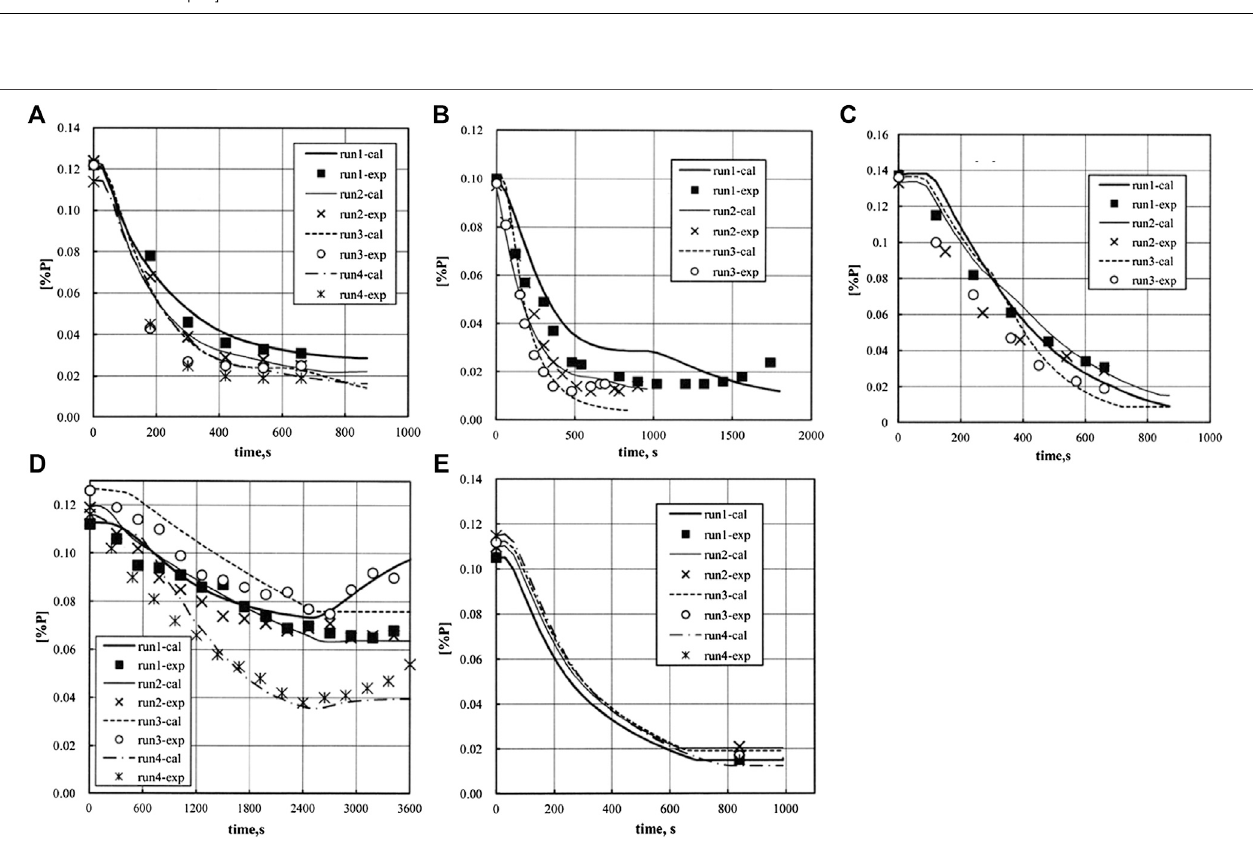
FIGURE 9 | Simulation results of the MPSR model for (A) laboratory furnace with FeO feeding all at once and bottom stirring but no oxygen blown; (B) laboratory furnace with FeO feeding all at once, bottom stirring and oxygen top blown; (C) laboratory furnace with bottom stirring and oxygen top blown, but no FeO addition; (D) laboratory furnace with FeO feeding in batches, bottom stirring and oxygen top blown; (E) Industrial converter with FeO feeding all at once, bottom stirring and oxygen top blown(Kitamura et al., 2014) [Figures 7 to 11 of (Kitamura et al., 2014), Copyright The Iron and Steel Institute of Japan].